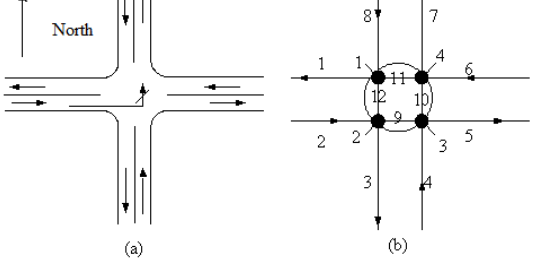
Fig. 3 Schematic diagram for navigable data representation of complex algorithm based on the transformation of road network